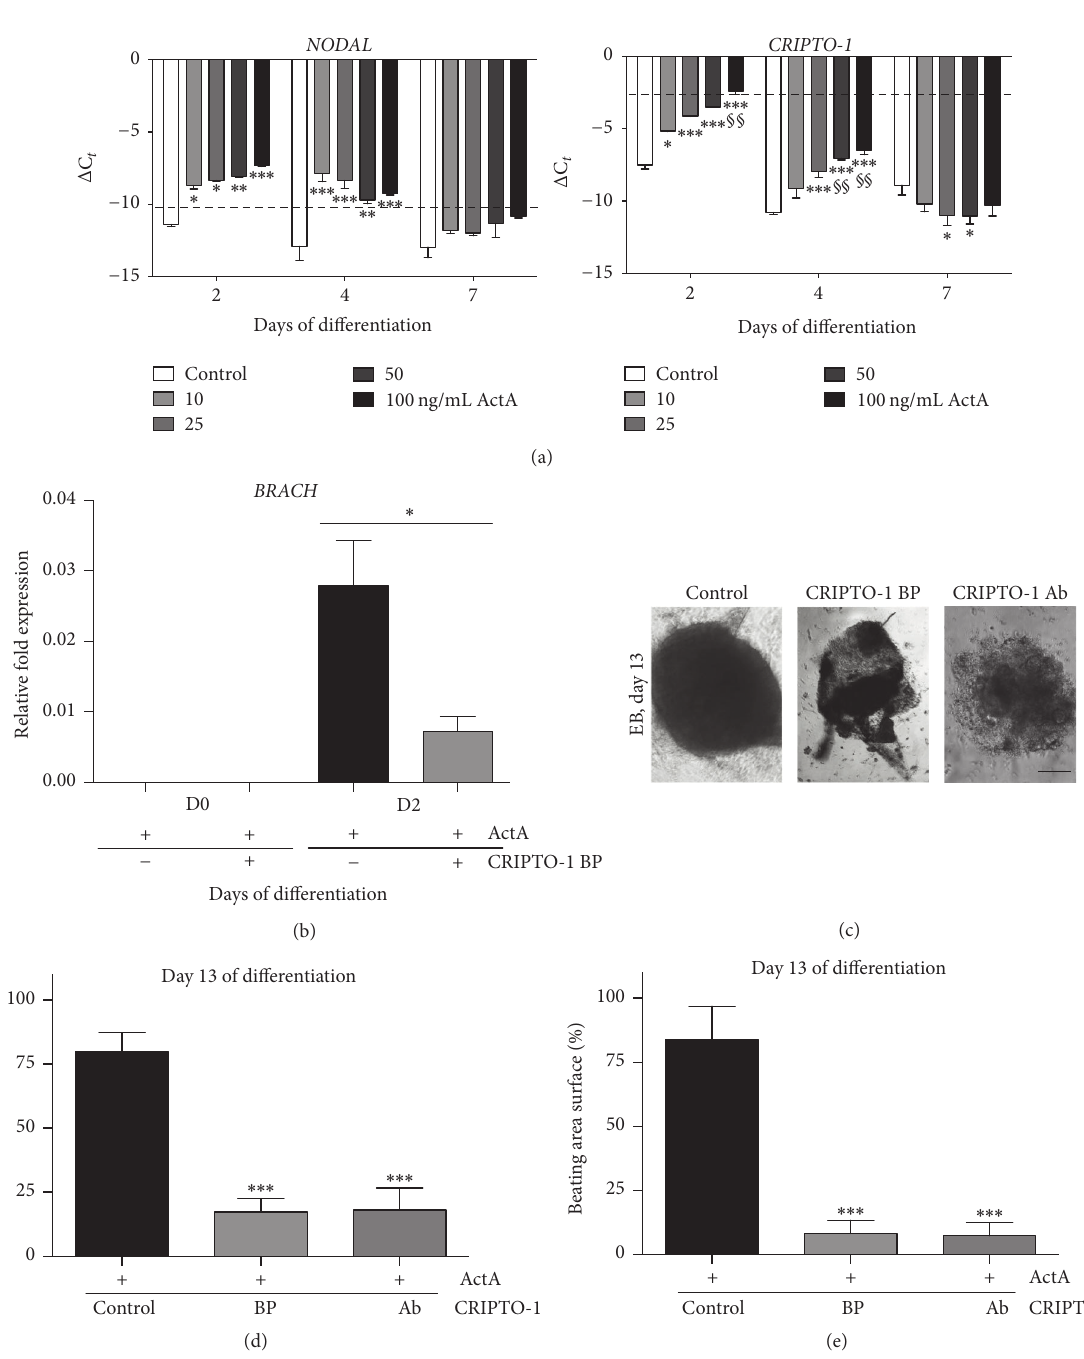
Figure 5: Human ESC-CM differentiation potential after CRIPTO-1 interference. CRIPTO-1 blocking peptide (BP) impaired ActA-directed in vitro cardiac differentiation. (a) Gene expression of the TGF- 𝛽 family members NODAL and CRIPTO-1 during a 13-day differentiation period. Dashed lines show basal expression levels of undifferentiated ESCs. (b) Normalized fold change of the mesodermal marker BRACH , measured at day 2 of differentiation after CRIPTO-1 BP treatment. Data, normalized for the housekeeping genes GAPDH , HPRT , and RPL13a , are representative of three independent experiments and expressed as mean ± SEM. (c) Brightfield pictures of ESC-CMs at day 13 of differentiation after CRIPTO-1 BP treatment or after addition of a human CRIPTO-1 antibody (Ab). (d) Percentage of contracting EBs and of (e) beating area surface in differentiated CMs pretreated with 100 ng/mL ActA and 5 𝜇 M CRIPTO-1 BP or pretreated with 100ng/mL ActA and a human CRIPTO-1 Ab (10 𝜇 M). Data, normalized for the housekeeping genes GAPDH , HPRT , and RPL13a , are representative of four independent experiments and expressed as mean ± SEM. Significant differences are indicated as 𝑃 < 0.05 : ∗ versus control; 𝑃 < 0.01 : ∗∗ versus control and §§ versus 10ng/mL ActA; 𝑃 < 0.001 : ∗∗∗ versus control. Scale bar = 200 𝜇